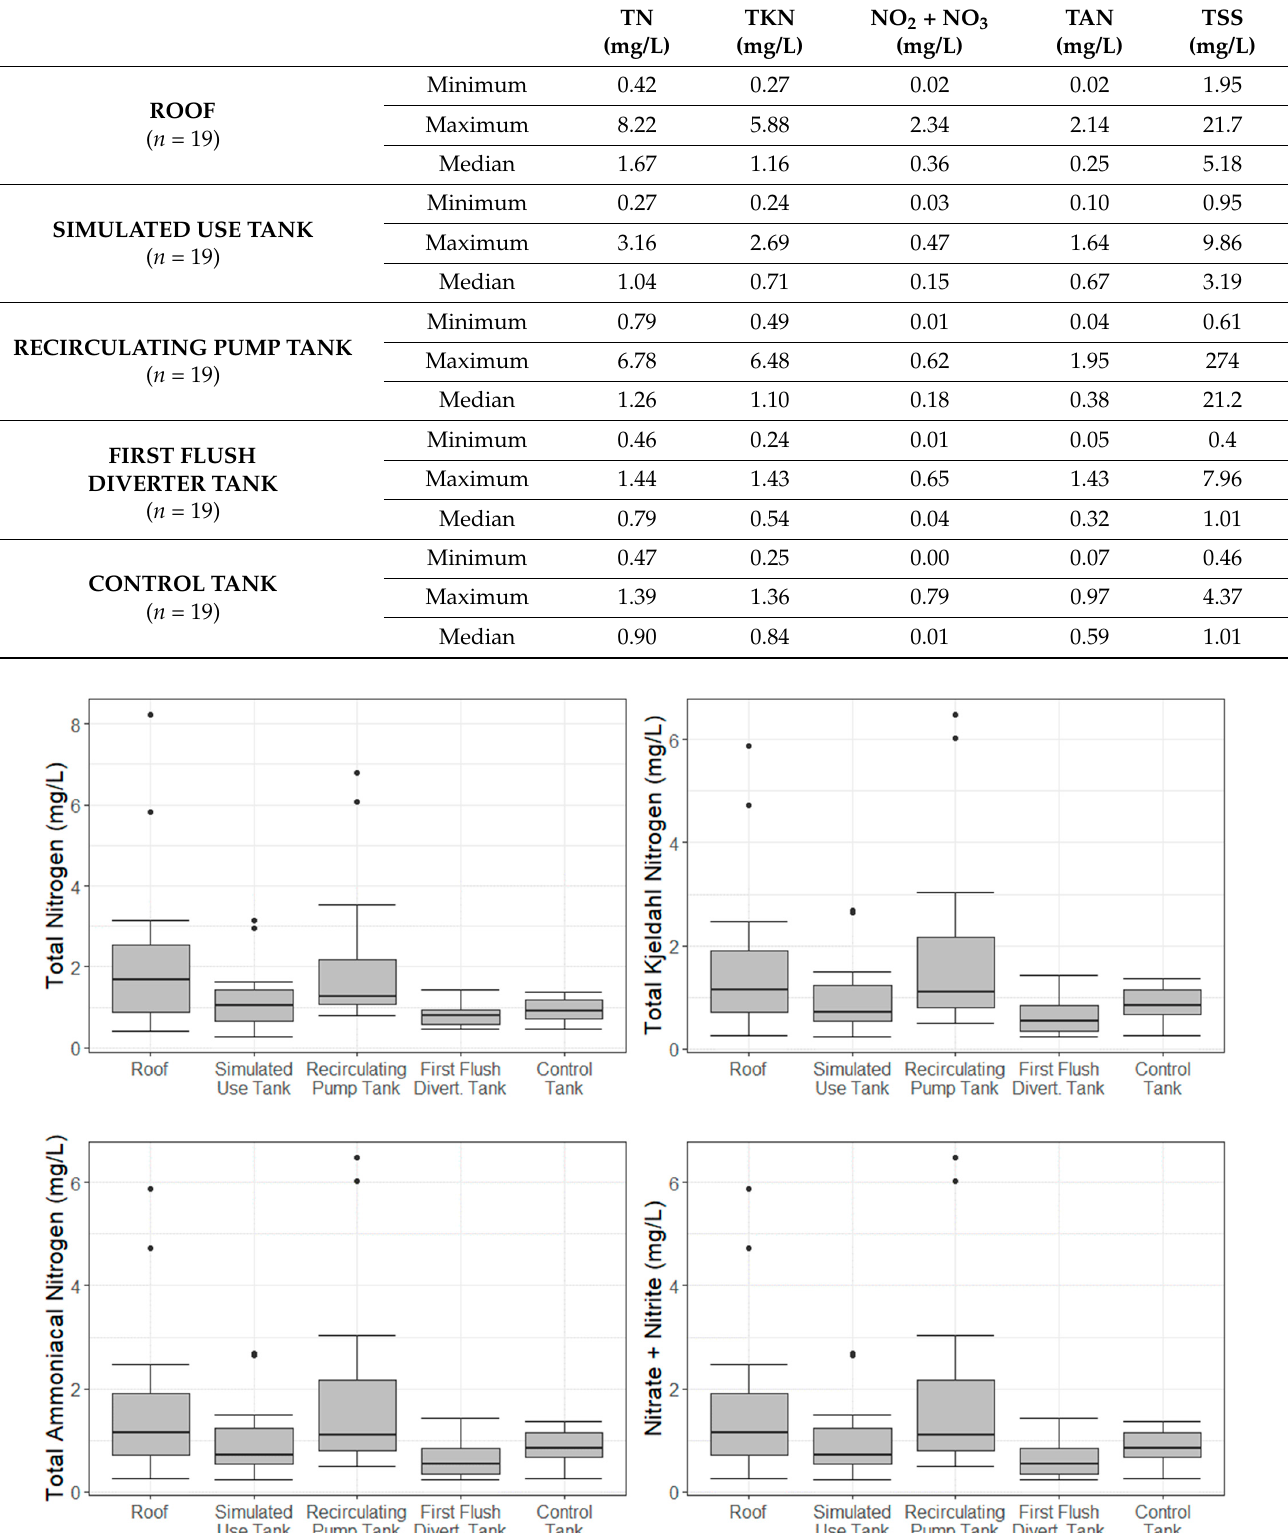
Table 1. Sample analysis results (minimum, maximum, and median) for roof runoff and rainwater storage tanks.